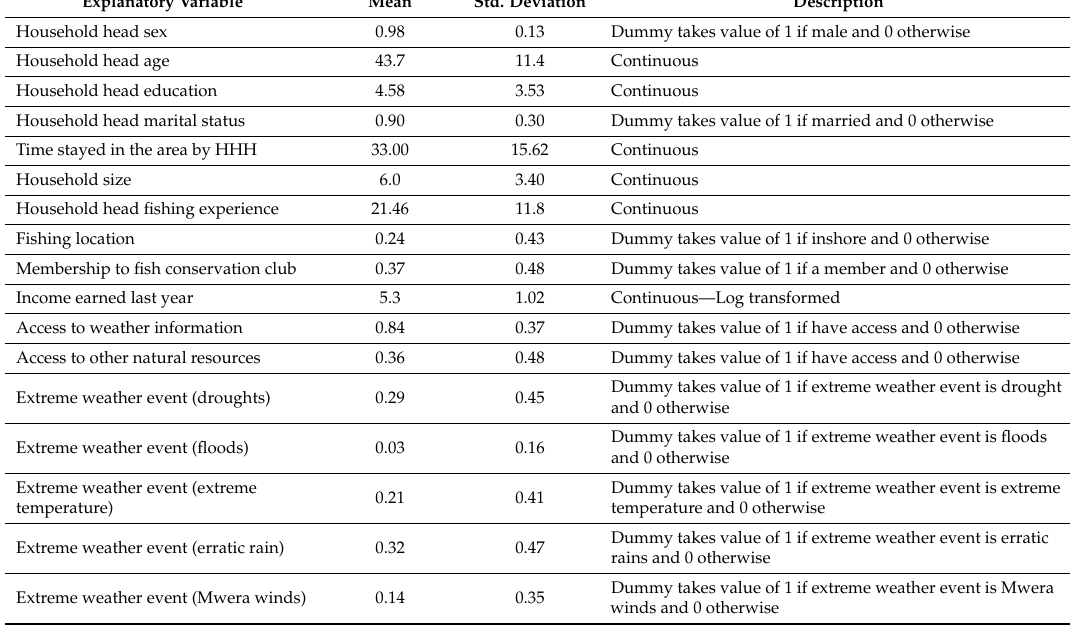
Table 2. Description of explanatory variables for the determinants of coping strategies for Nkhotakota fishers ( n =